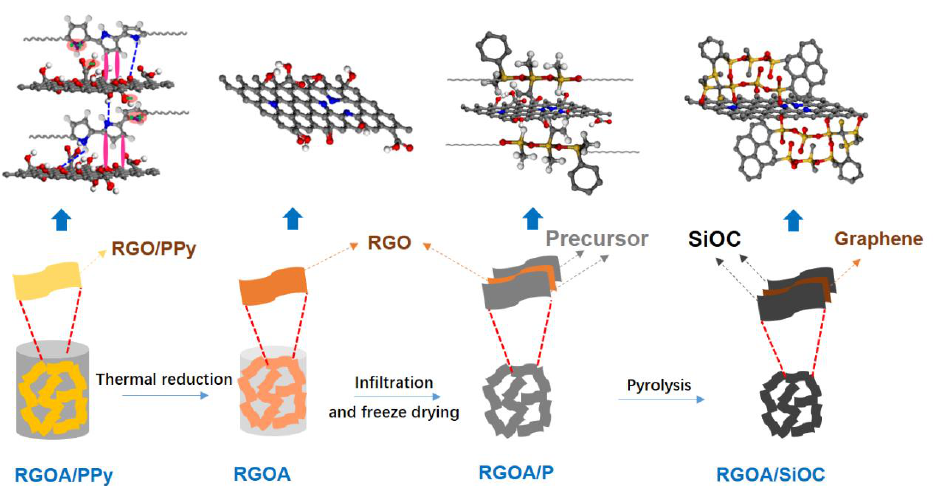
Figure 1. Schematic of the bottom-up fabrication process of RGOA/SiOC nanocomposites and the evolution of chemical structures and interactions. The hydrothermally synthesized RGOA/PPy aerogels were first reduced at 600 – 1000 °C in Ar, then infiltrated by a polymeric solution to obtain the RGOA/P precursors, which were subsequently freeze-dried and pyrolyzed at 1000 °C to obtain the RGOA/SiOC nanocomposites.